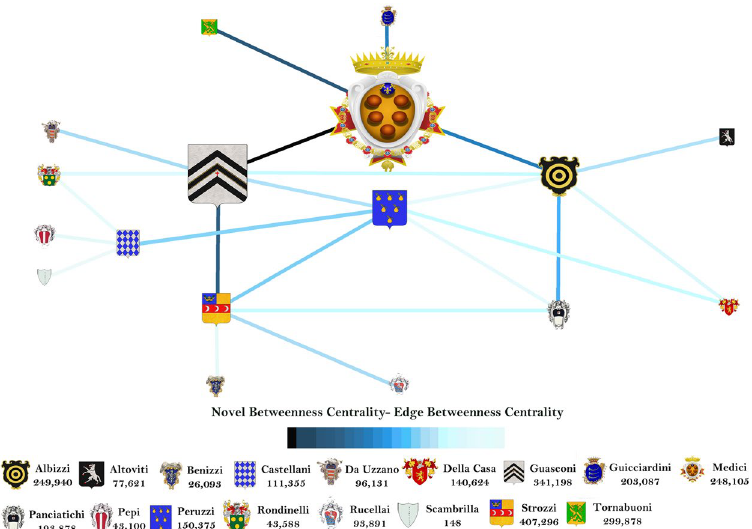
Figure 6. Standard betweenness for the Florence Families network. Vertices have the same intrinsic relevance, equal to 1. Each family is represented by its own emblem, whose size is proportional to the corresponding vertex betweenness centrality. The edge betweenness is shown by coloured edges, ranging from black (maximum value) to cyan (minimum